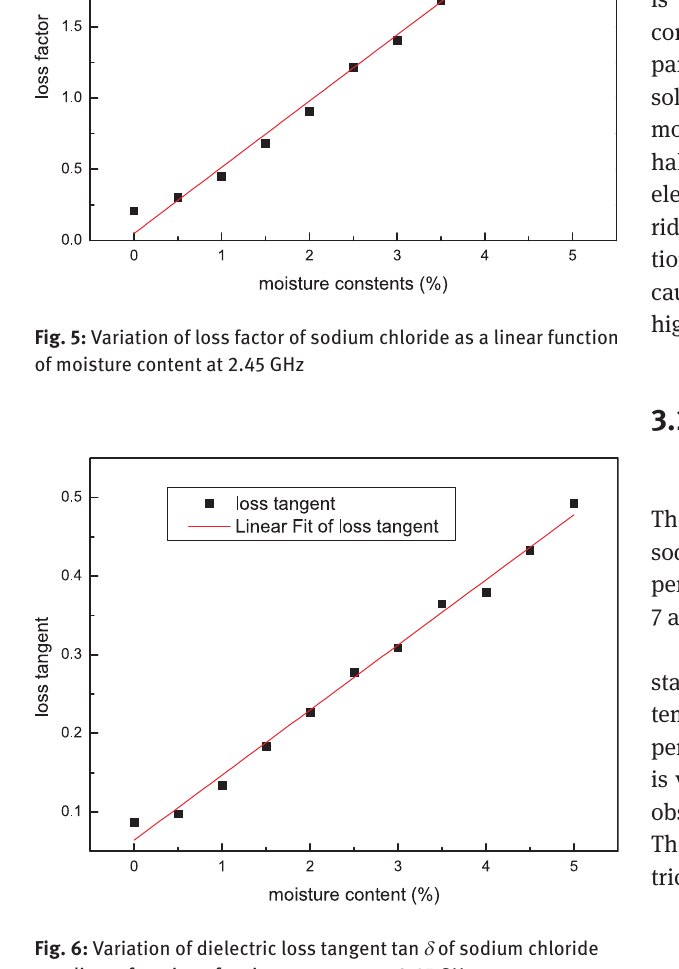
Fig. 6: Variation of dielectric loss tangent tan d of sodium chloride as a linear function of moisture content at 2.45 GHz